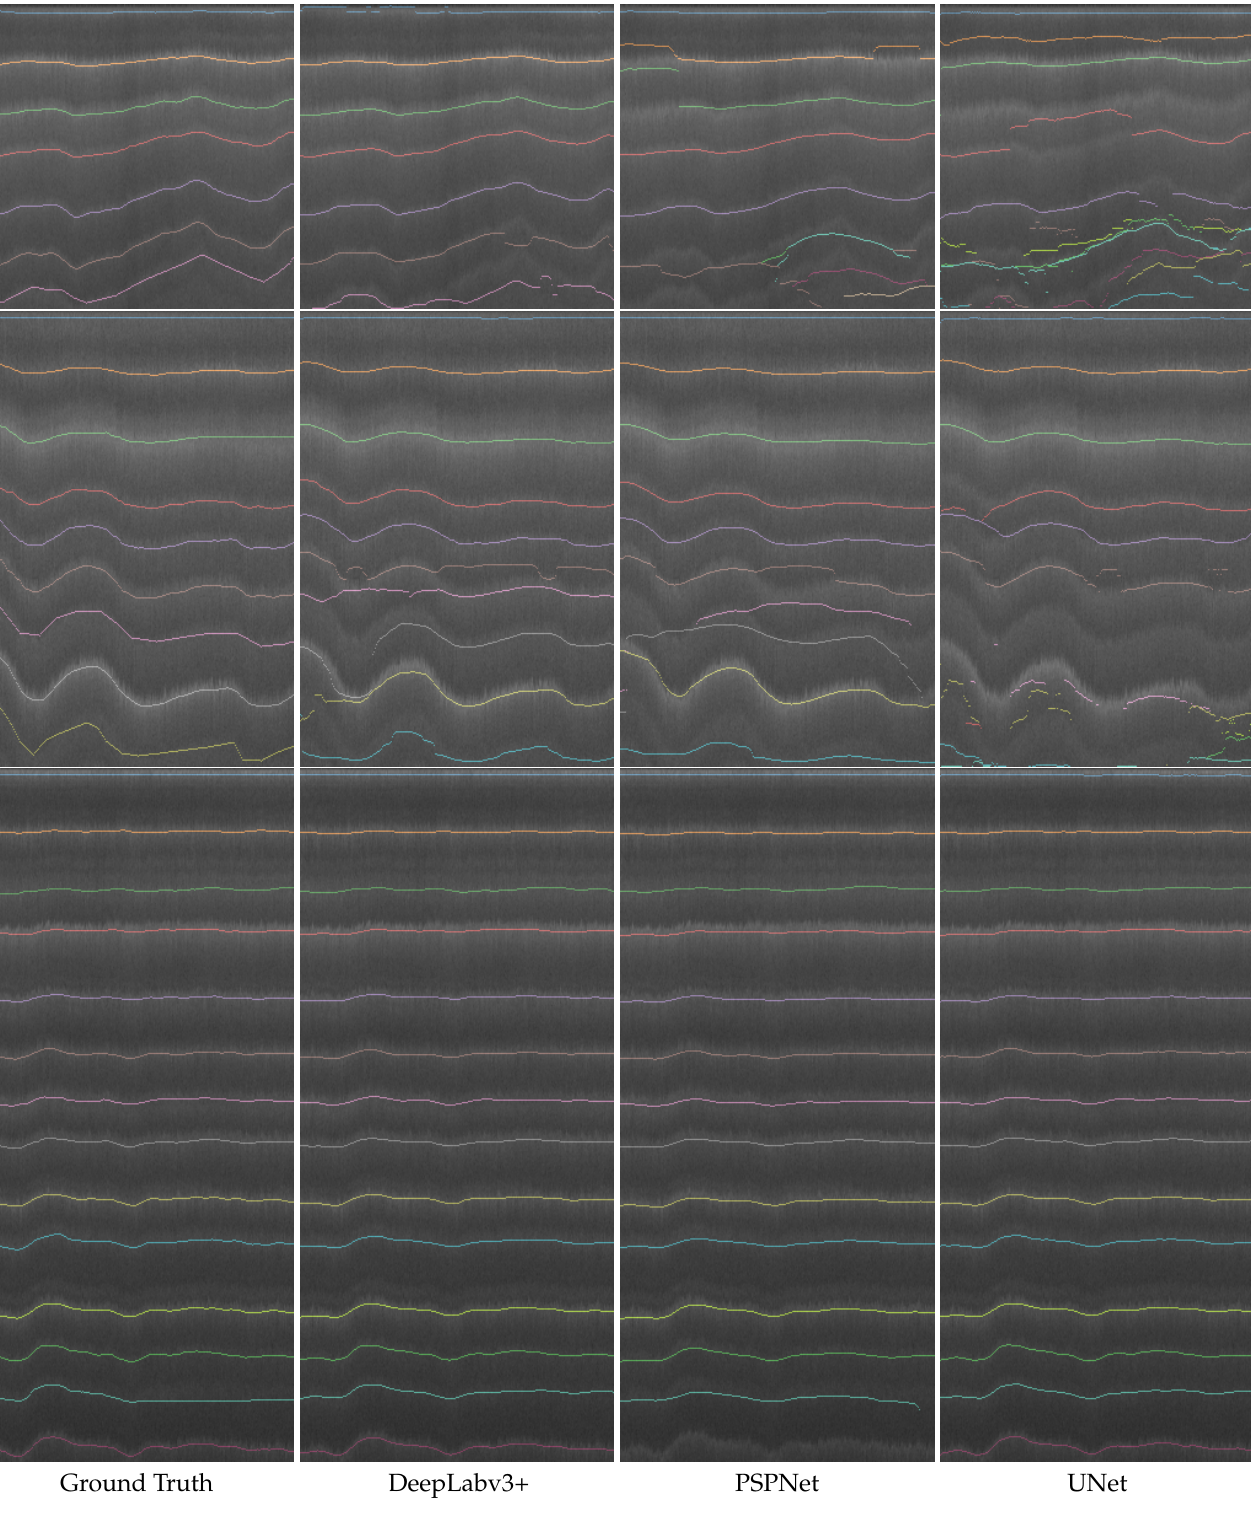
Ground Truth DeepLabv3+ PSPNet UNet Figure 12. Radar images overlaid with Ground Truth layers ( first column ) and layers predicted from the three FCNs: DeepLabv3+ ( second column ), PSPNet ( third column ), and UNet ( fourth column ). The results shown are from each network’s best output in terms of mean IoU (Table 3). More examples are in Figure